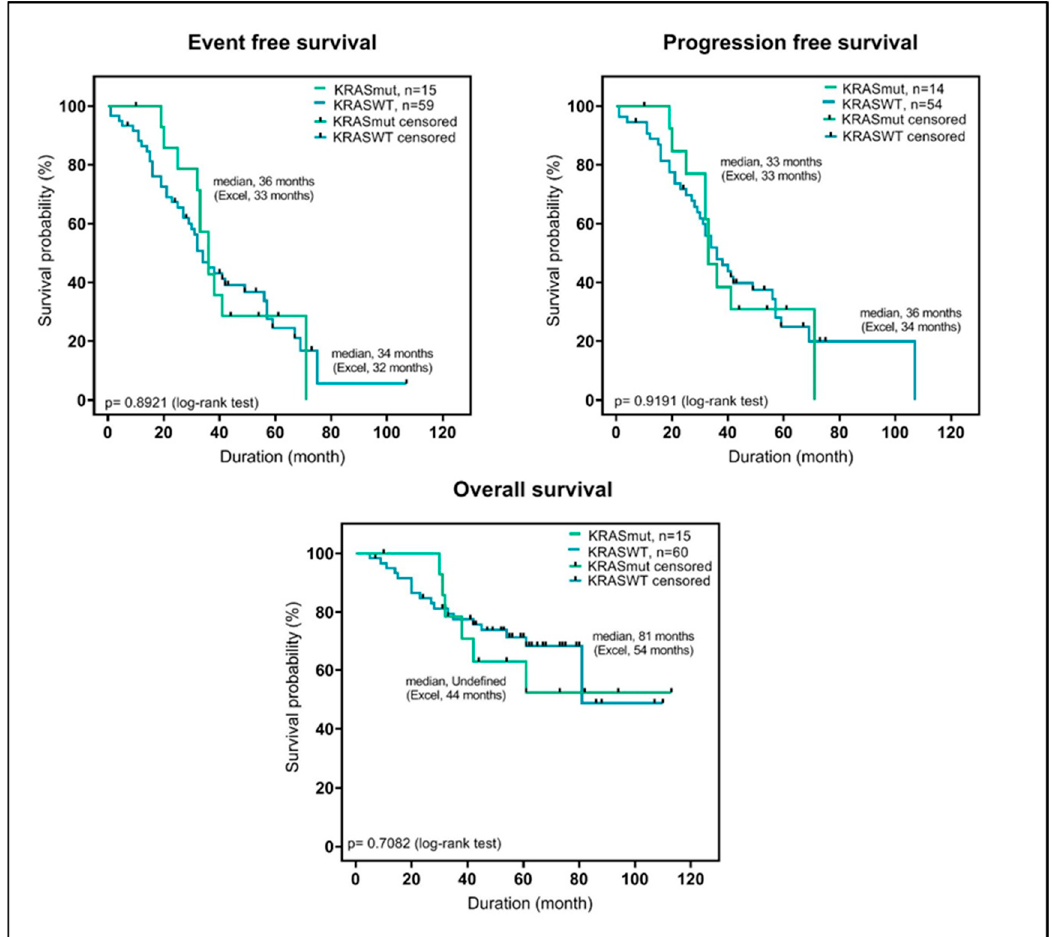
Figure 2. Kaplan Meier plots, showing the difference in overall survival, event free survival, and progression free survival between MM cases with or without KRAS mutation.